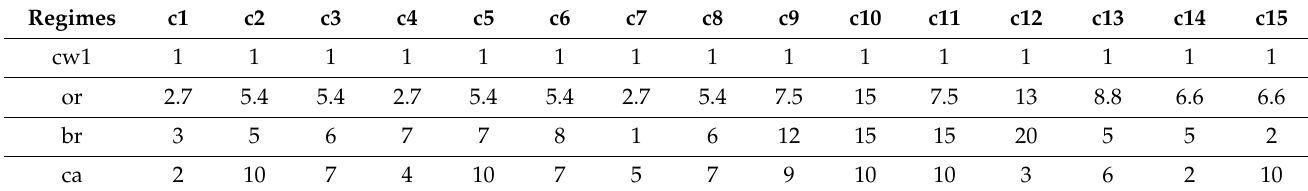
Table 4. Weight-regimes of indifferent-weights (“cw1”), Kalifa et al. (“or”), Bruggemann (“br”) and Carlsen